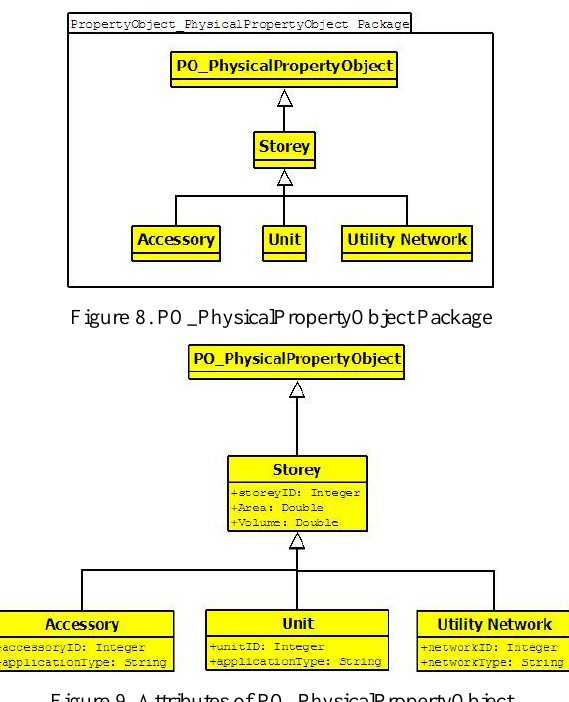
Figure 9. Attributes of